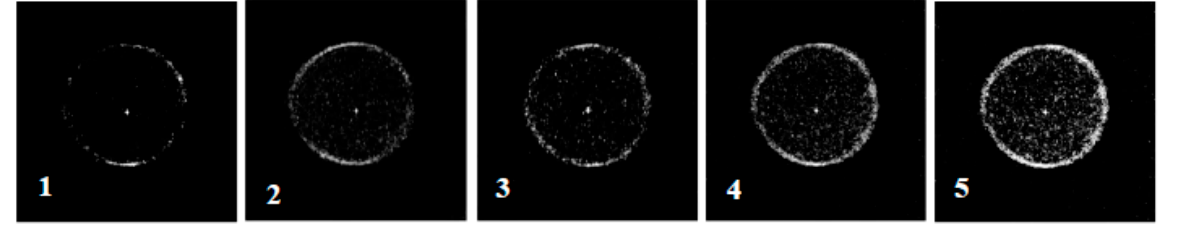
Figure 13. Pore images of dry rock samples.